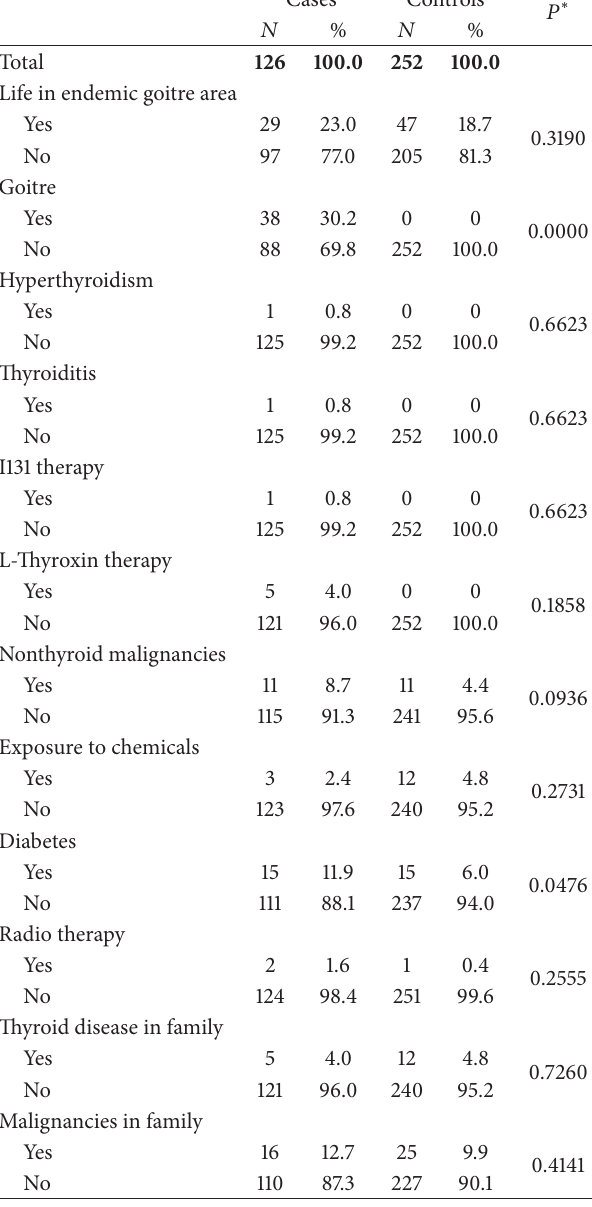
∗ Univariate logistic regression